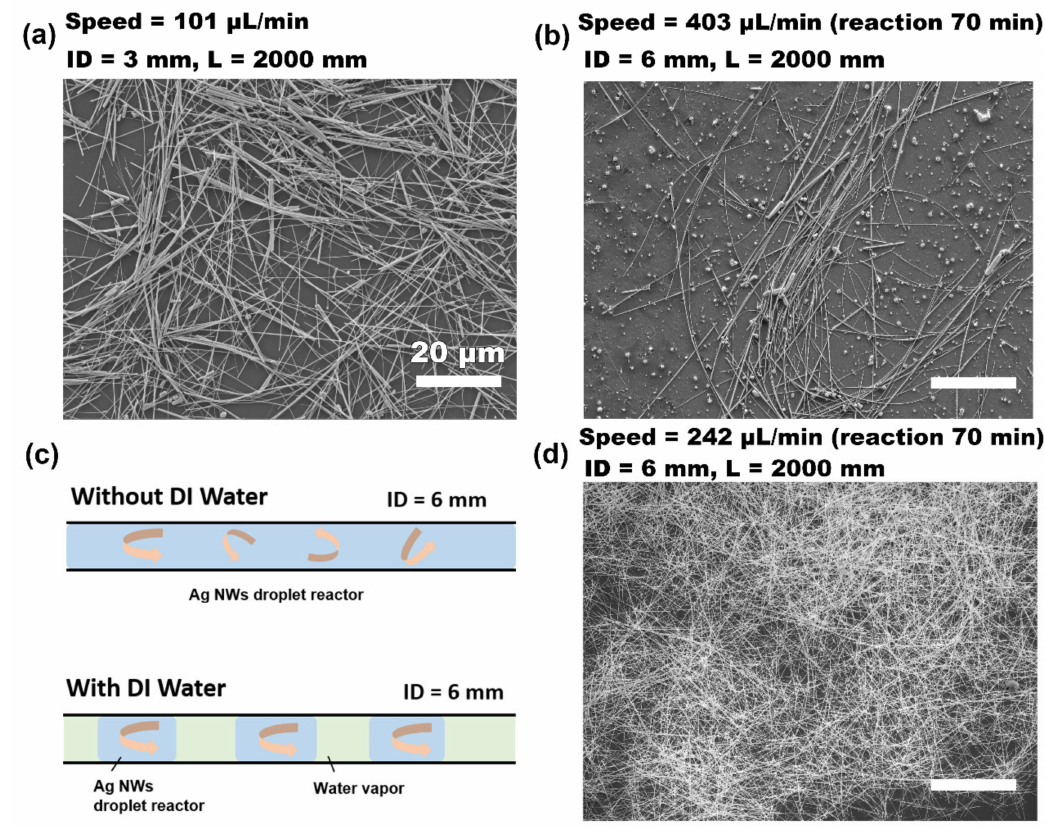
Figure 2. Diagrams of droplet flow-chemistry-processed Ag NWs against the inner diameters of PTEF pipe channel and water carrier phase. ( a , b ) SEM images of Ag NWs produced without DI water under pipe inner diameters of 3 and 6 mm, respectively. ( c ) The state of the fluid segment in the pipeline with or without deionized water. ( d ) SEM image of Ag NWs produced with DI water under a pipe inner diameter of 6